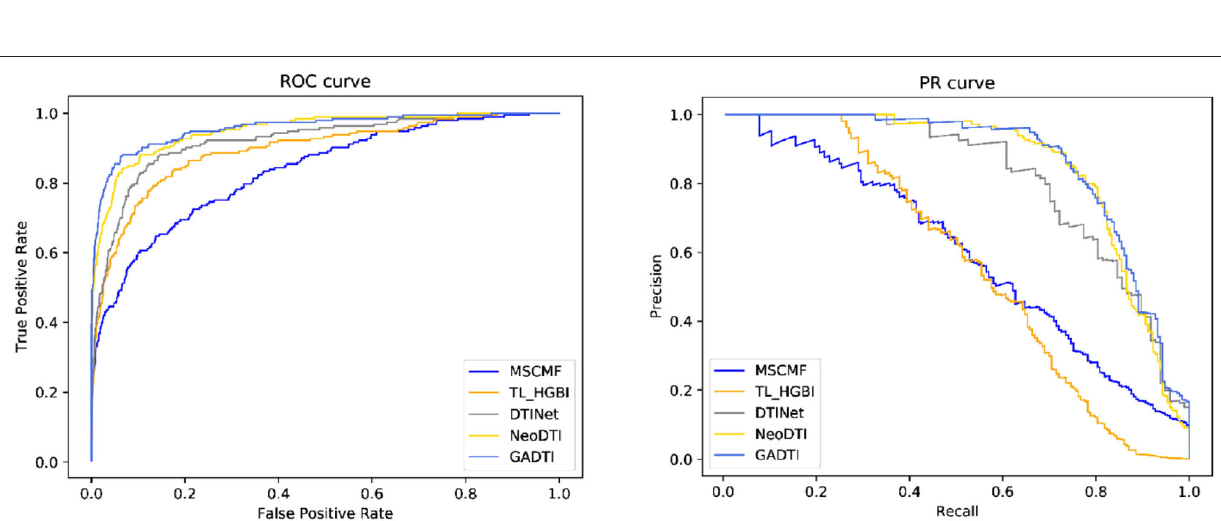
FIGURE 4 | Comparison between MSCMF, TL_HGBI, DTINet, NeoDTI, and GADTI in terms of AUROC and AUPRC based on 10-fold cross-validation (#positive: #negative = 1:10).